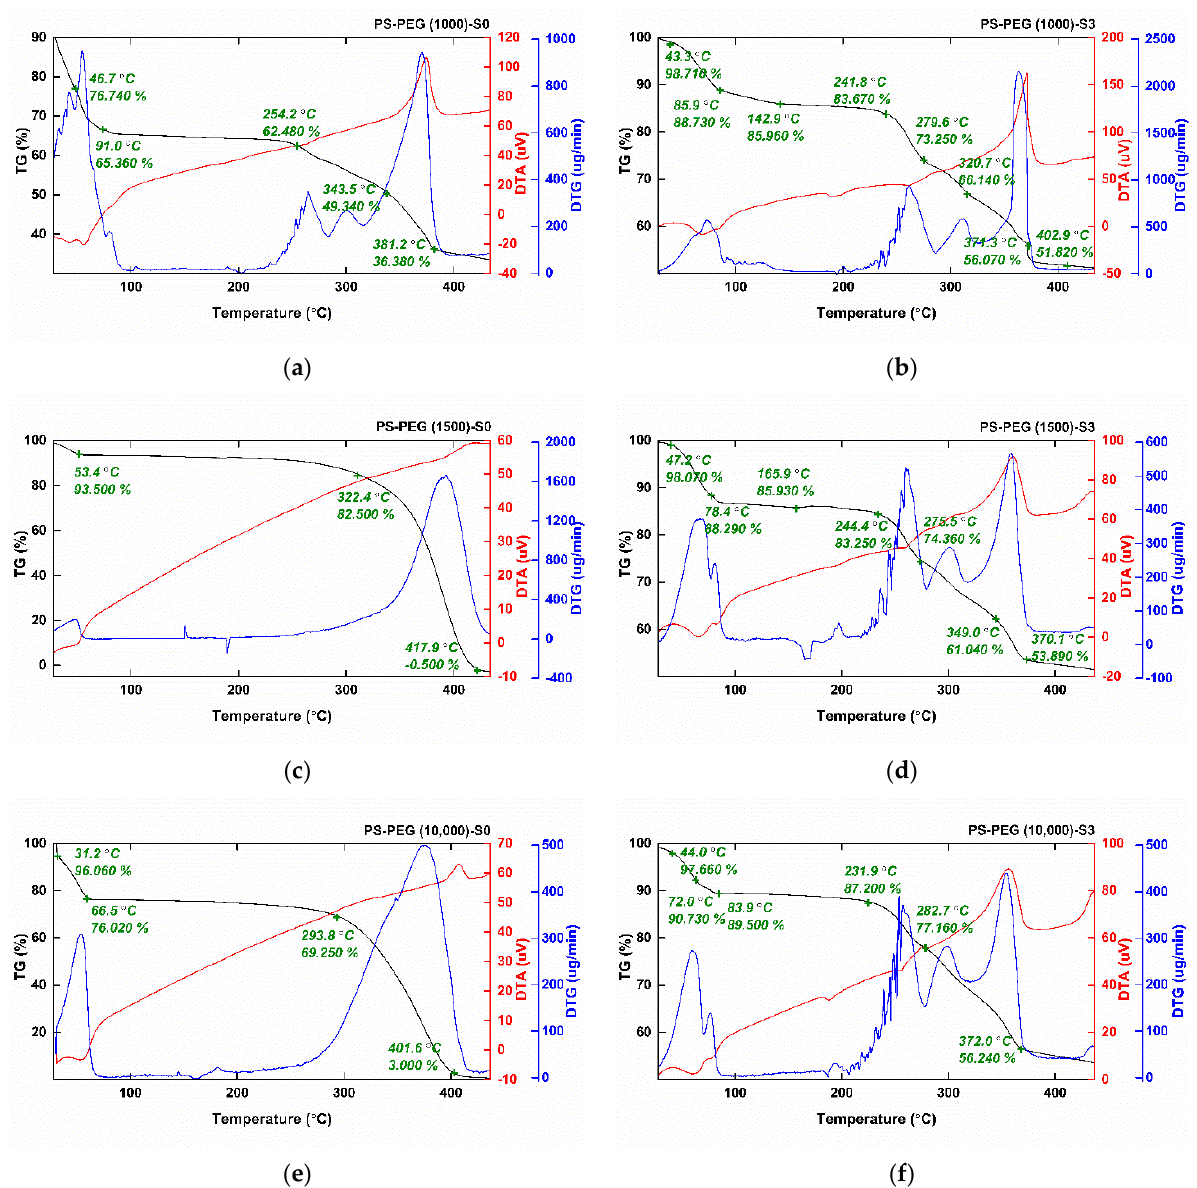
Figure 4. TGA thermograms of the PbO doped the crosslinked PS-b-PEG block copolymers materials: ( a ) PS-PEG (1000)-S0; ( b ) PS-PEG (1000)-S3; ( c ) PS-PEG (1500)-S0; ( d ) PS-PEG (1500)-S3; ( e ) PS-PEG (10,000)-S0; ( f ) PS-PEG (10,000)-S3. Black, blue and red lines indicate the thermogravimetry (TG), derivative thermogravimetry (DTG), and differential thermal analysis (DTA) values respectively.